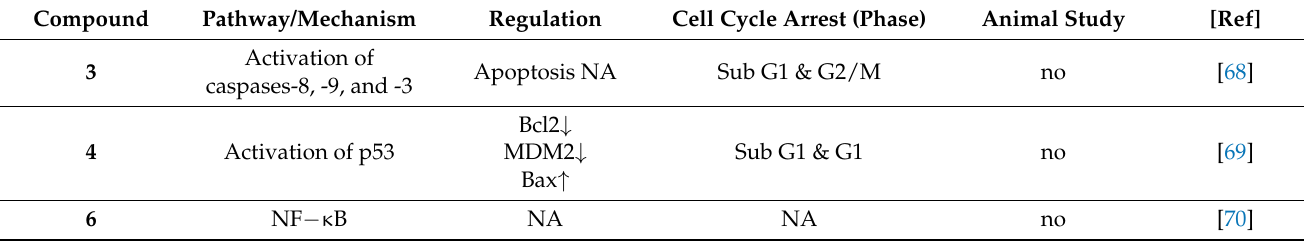
Table 1. Summarized information on UA analogs (C3 modifications).